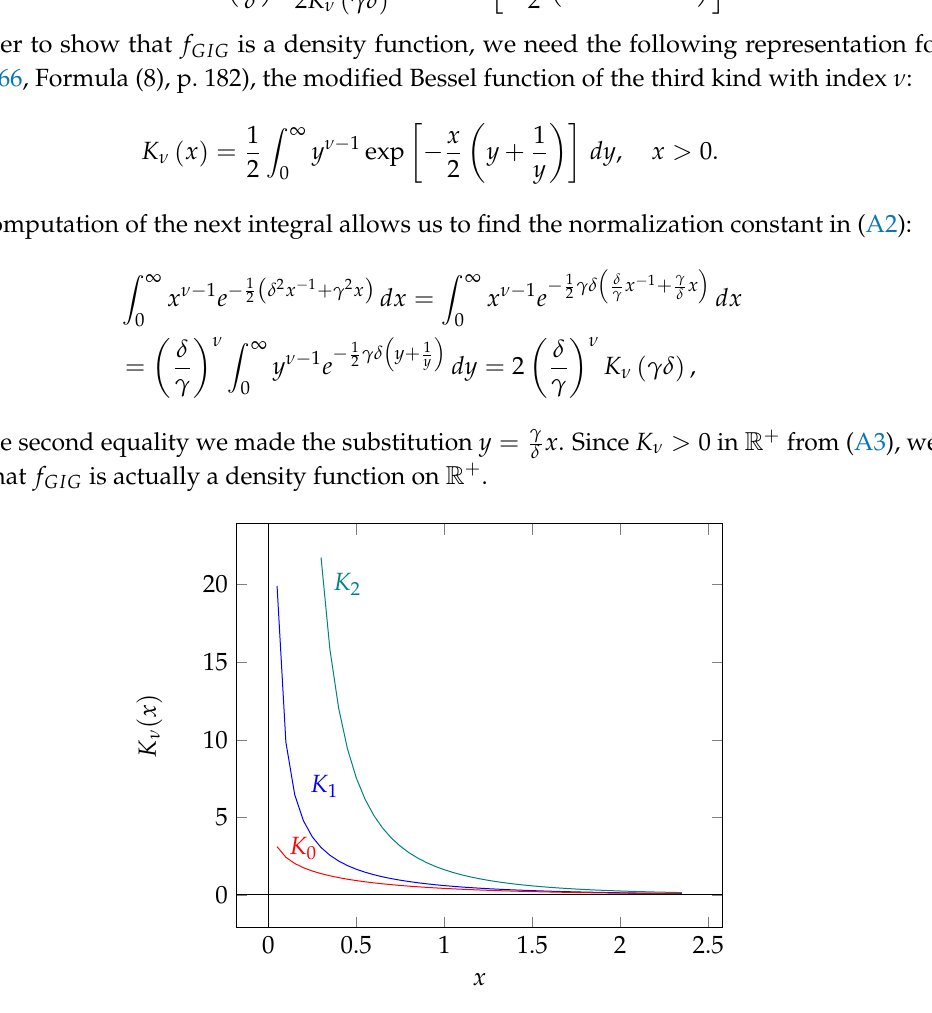
Figure A1. K 0 , K 1 , K 2 are the modified Bessel functions of the first three, nonnegative, integer orders,